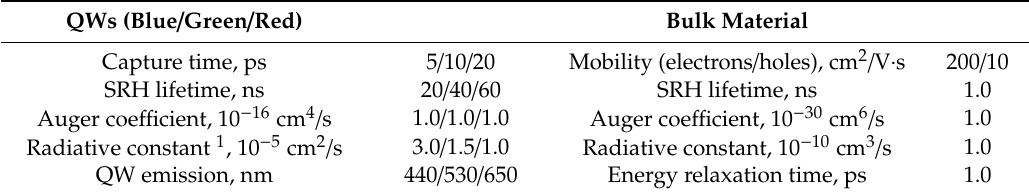
Table 1. QW and bulk material